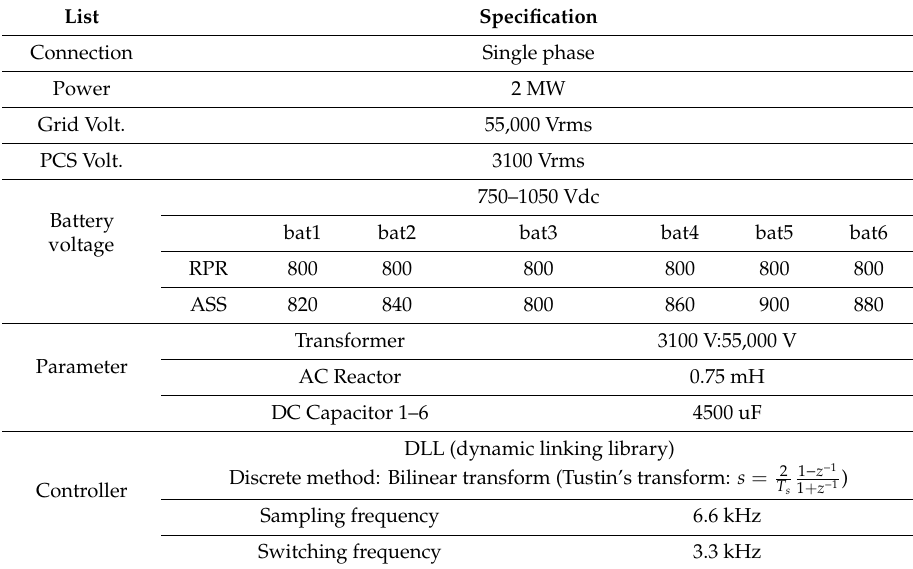
Table 3. Simulation